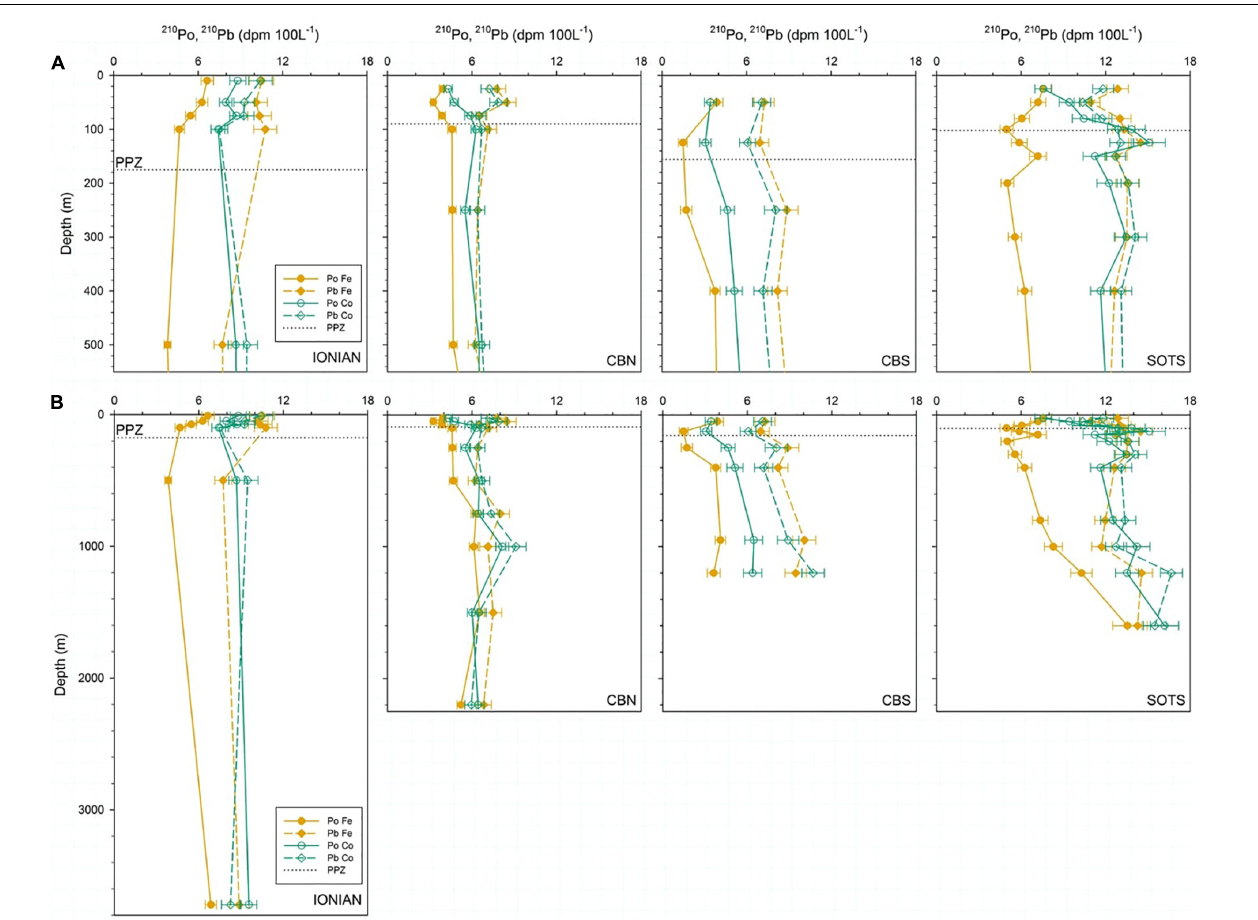
FIGURE 3 | Vertical activity profiles for total 210 Po (solid lines) and total 210 Pb (dashed lines) measured in duplicate samples using the Fe(OH) 3 (yellow, closed symbols) and Co-APDC (green, open symbols) precipitation methods [Fe(OH) 3 TOT siph and Co-APDC TOT protocols in Figure 1 ]. (A) Shows only the upper 500 m of the water column, while (B) shows the entire profiles. Same scale is used for the x - and y -axis to facilitate comparison. The base of the primary production zone (PPZ) is denoted by the horizontal dotted